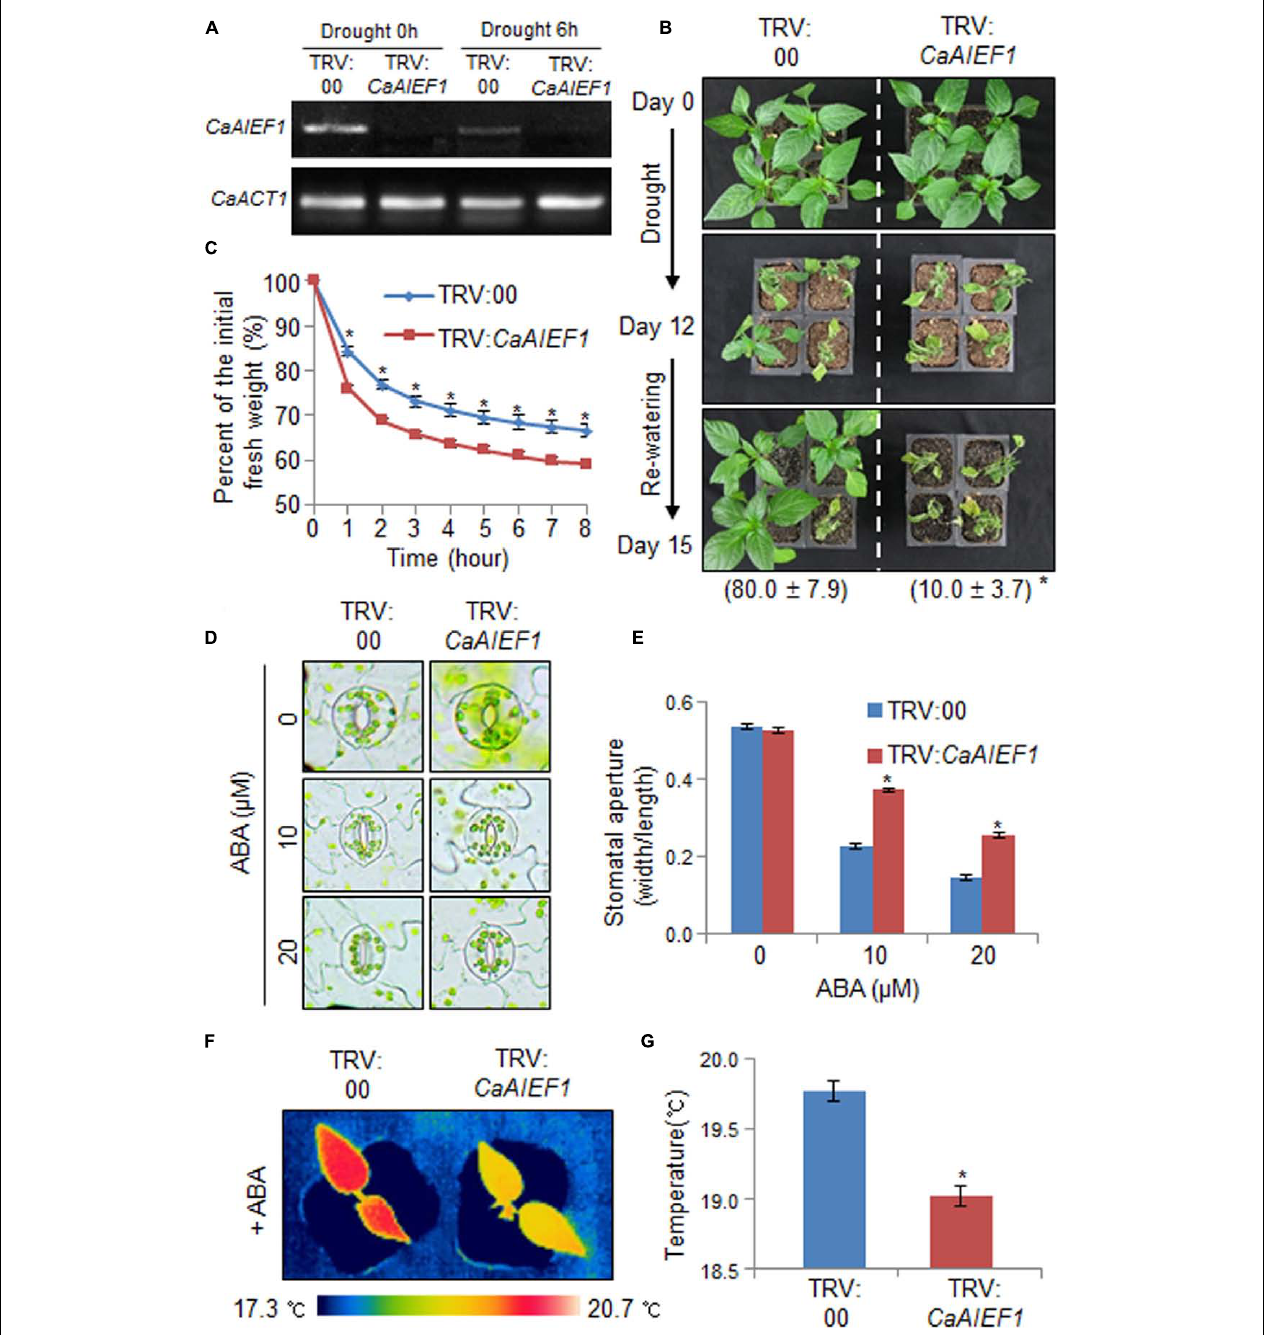
FIGURE 3 | Reduced tolerance of CaAIEF1 -silenced pepper plants to drought stress. (A) Reverse transcription-polymerase chain reaction (RT-PCR) analysis of CaAIEF1 expression in CaAIEF1 -silenced pepper plants in normal and drought stress conditions. The pepper Actin1 ( CaACT1 ) gene was used as an internal control. (B) Drought sensitivity of control (TRV2:00) and CaAIEF1 -silenced pepper (TRV2: CaAIEF1 ) plants. Four-week-old plants of each line were subjected to drought stress by withholding watering for 12 days. The plants were re-watered for 3 days, after which representative images were taken and the percentages of surviving plants were calculated. Data represent the mean ± standard error of three independent experiments, each evaluating 30 plants. (C) Transpirational water loss from the leaves of control and CaAIEF1 -silenced pepper plants. Leaves were detached and the fresh weights of each line were measured every hour. Data represent the mean ± standard error of three independent experiments, each evaluating 30 plants. (D,E) ABA-induced stomatal closure in control and CaAIEF1 -silenced pepper plants. Leaf peels were incubated with 10 and 20 µ M ABA, after which representative images were taken (D) , and the stomatal apertures of each line were measured (E) . (F,G) Leaf temperatures of control and CaAIEF1 -silenced pepper plants after exposure to ABA. Control and CaAIEF1 -silenced pepper plants were sprayed with 50 µ M ABA. After 6 h, representative thermographic images were taken (F) , and the mean leaf temperature was measured using the first and second leaves of each line ( n = 18) (G) . All data represent the mean ± SE of three independent experiments. Asterisks indicate significant differences (Student’s t -test; P < 0.05).